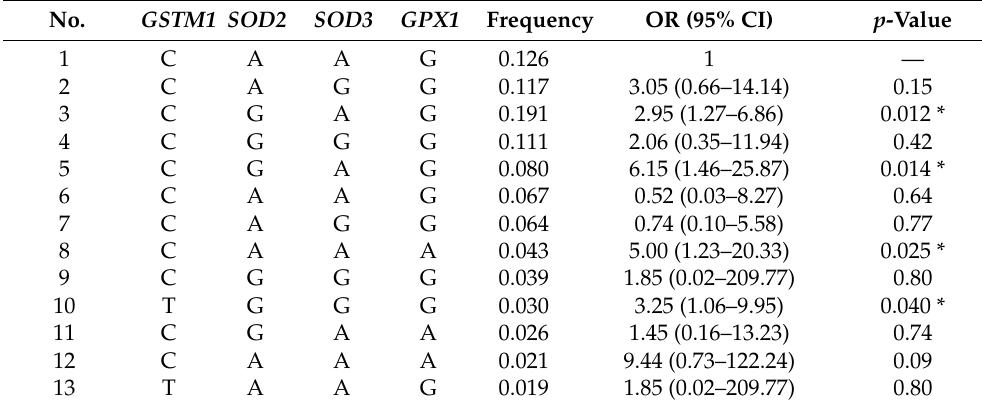
Table 3. Genotype combination analysis of risk alleles for obesity.